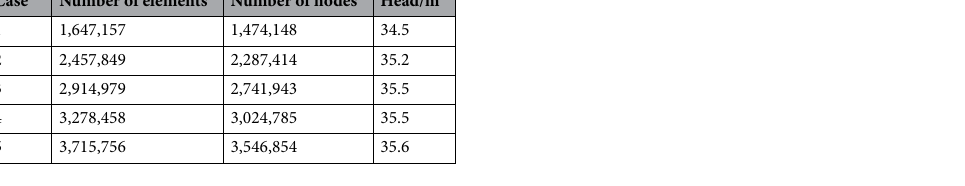
Table 2. Mesh-dependence verification.